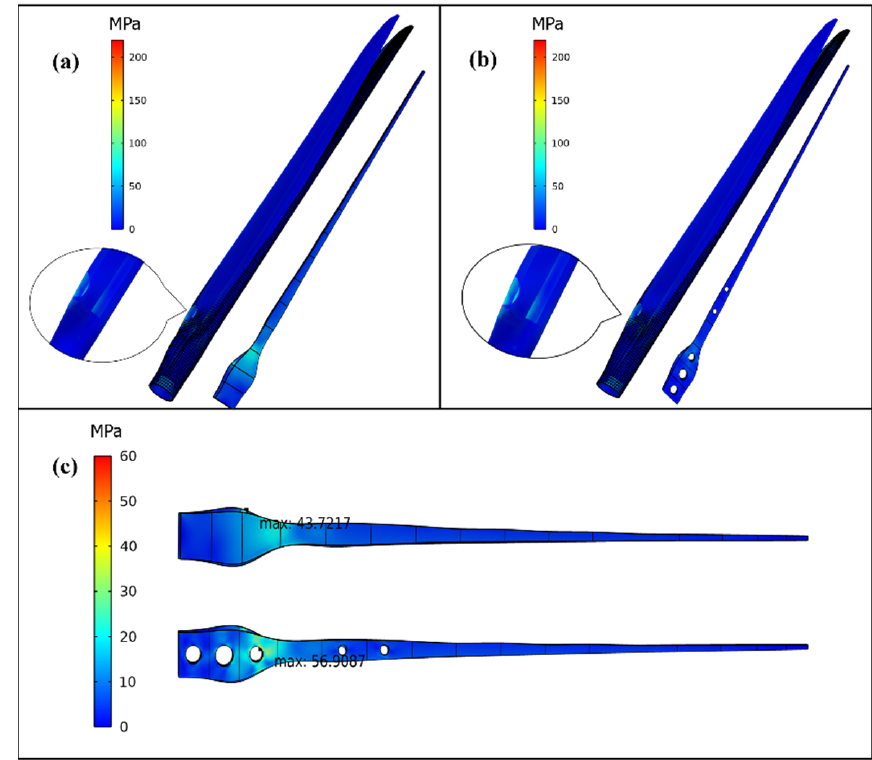
Figure 8. Stress nephogram before and after optimization: ( a ) surface Mises stress of the initial blade; ( b ) surface Mises stress of the optimal blade; ( c ) the Mises stress of the shear webs in initial and optimal blade.